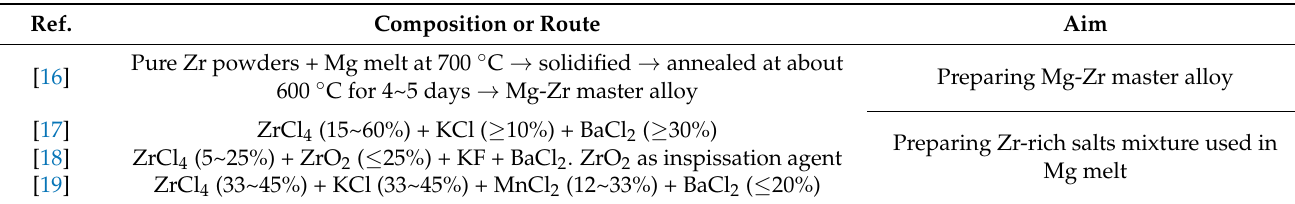
Table 1. Early patents of Zr alloying methods in Mg alloy.